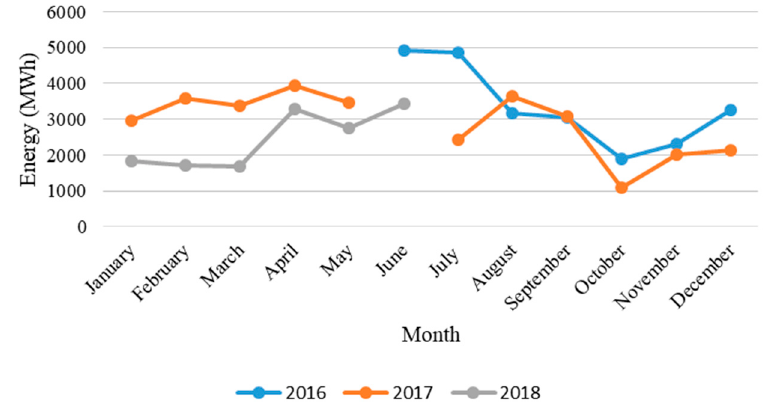
Figure 7. Energy production from the proposed wind farm consisting of five wind turbines (rotor diameter: 140 m).